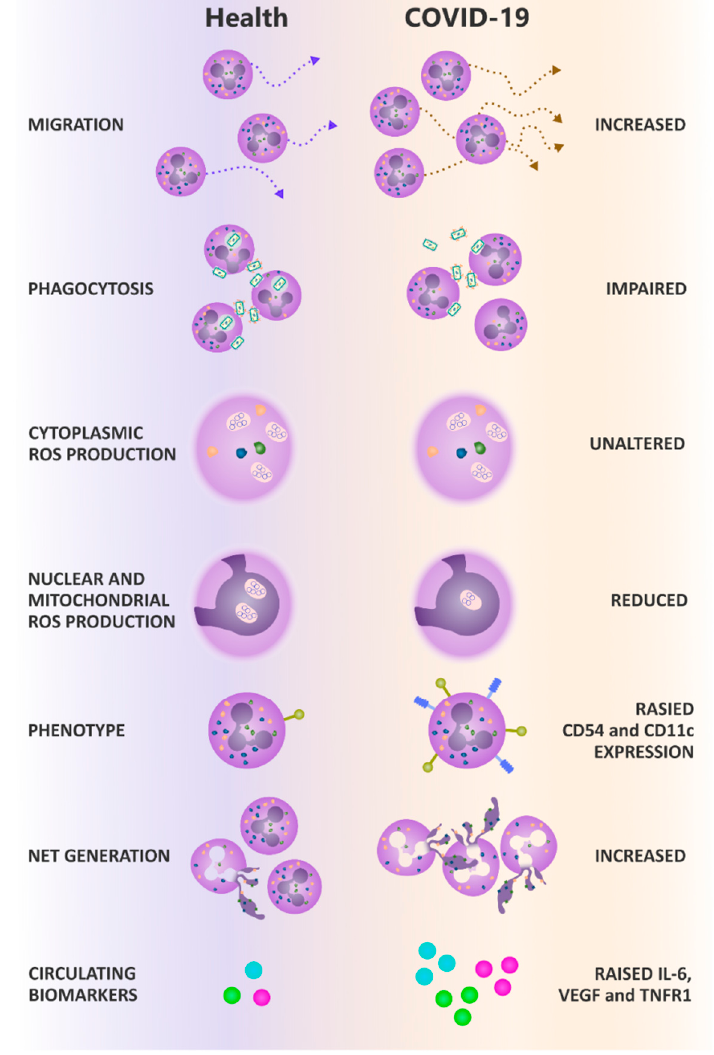
Figure 7. Summary of results. Compared to AMC, neutrophils isolated from non-ICU COVID-19 pa- tients demonstrate increased migration, impaired phagocytosis and reduced nuclear/mitochondrial ROS generation. COVID-19 neutrophils have altered phenotypes, displaying increased expression of migration markers CD54 and CD11b. COVID-19 patients also display elevated NETosis, both ex vivo and in the circulation, and elevated pro-inflammatory cytokines. This contributes to disease pathogenesis in